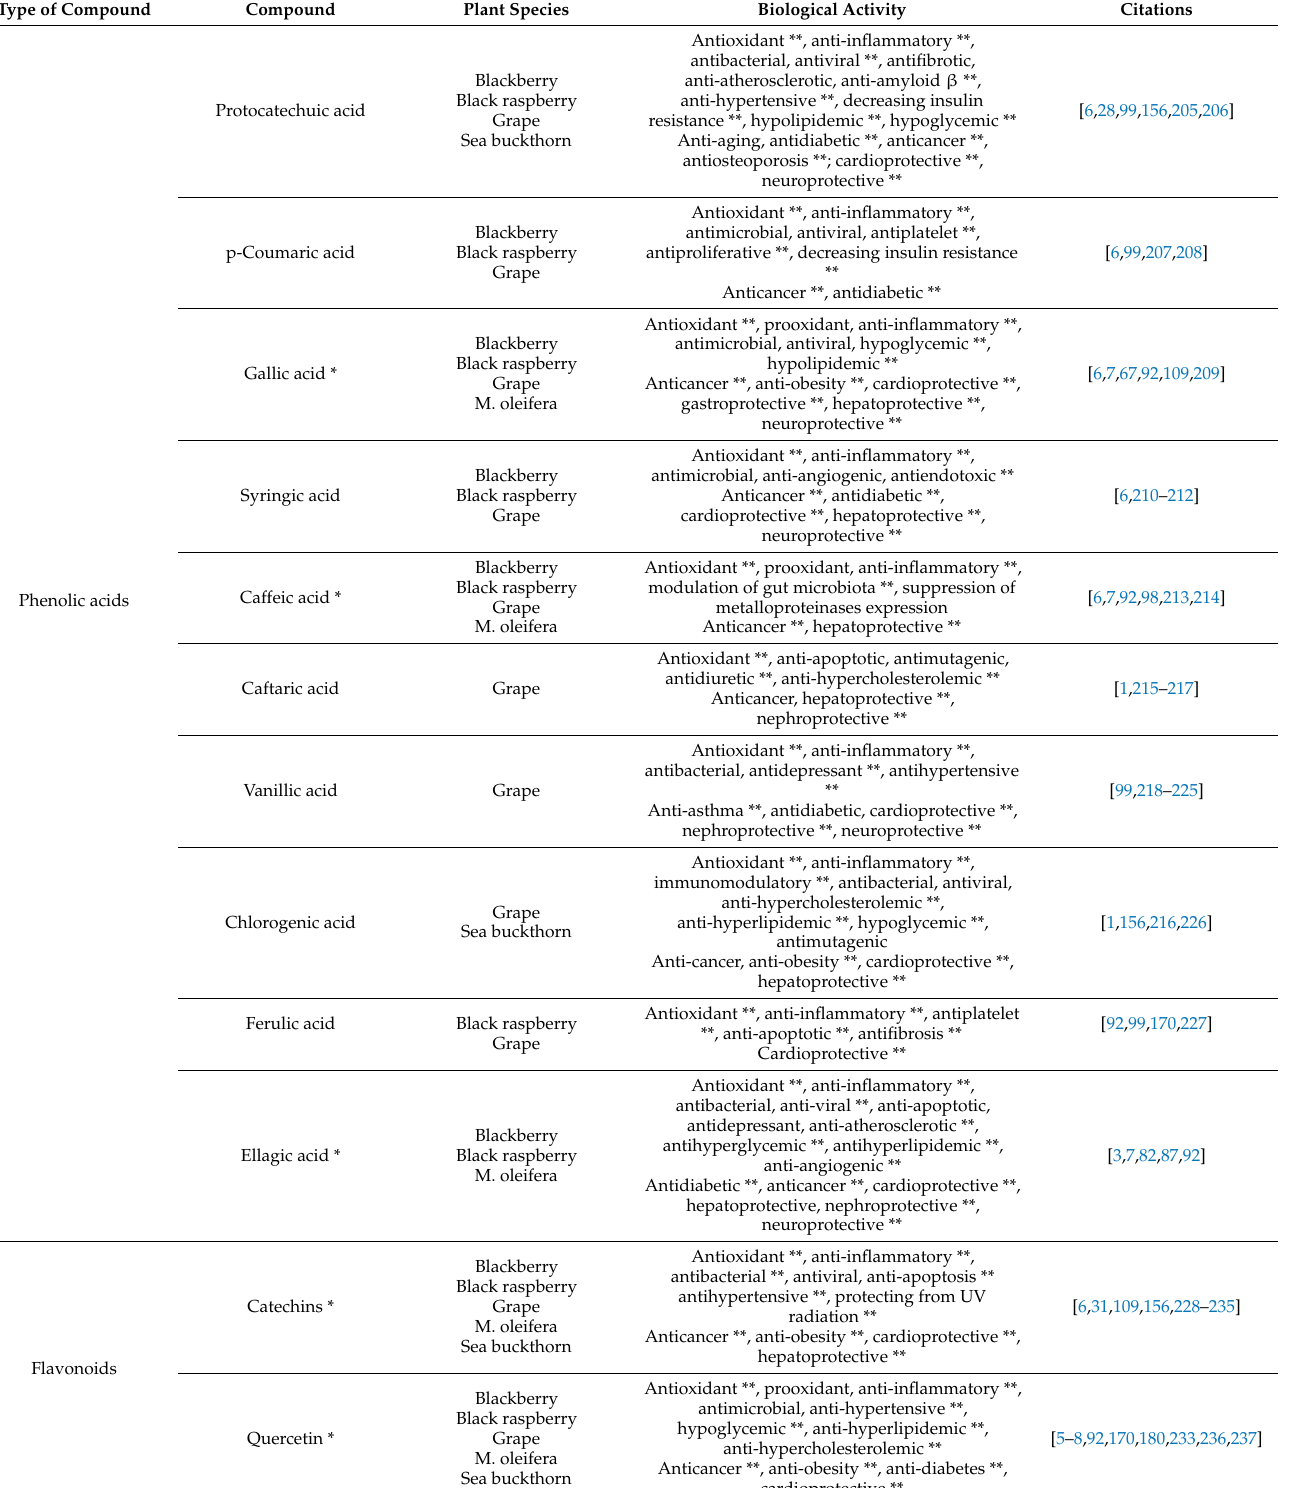
Table 1. Compounds isolated from seeds usually eaten with whole fruits and their biological